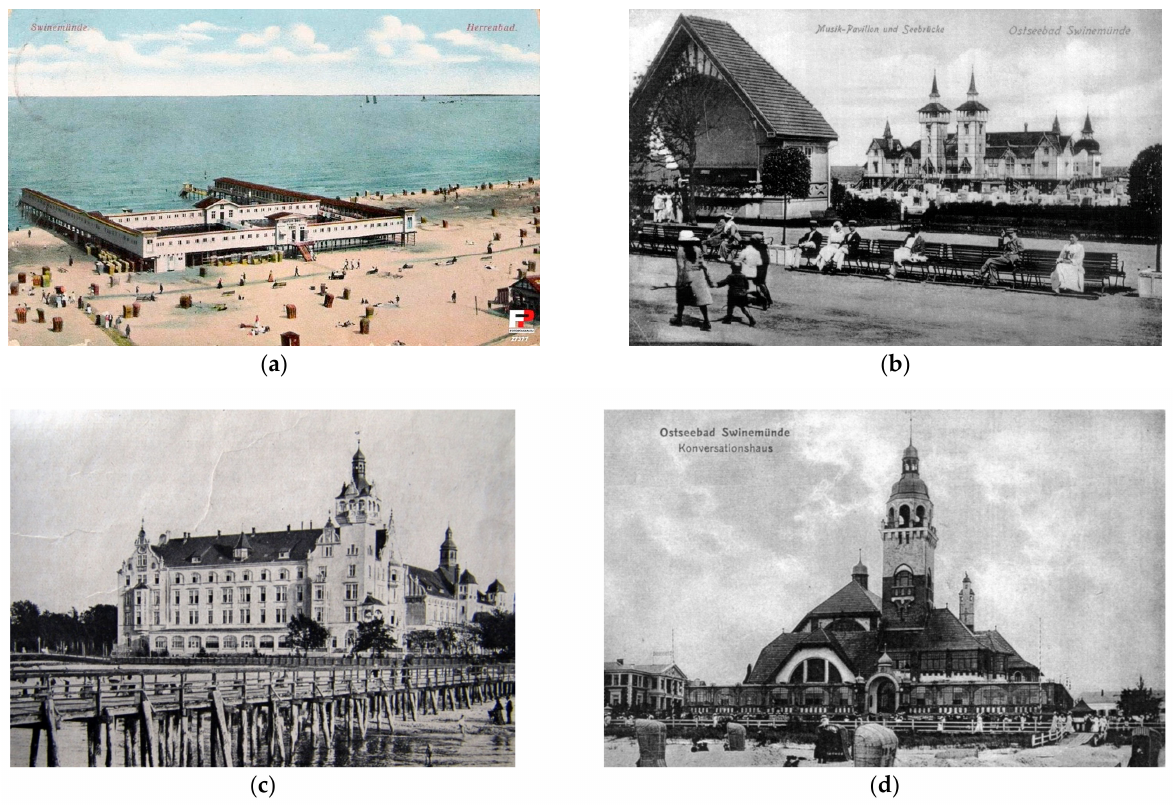
Figure 3. Nodal elements: ( a ) Swimming area in ´Swinouj´scie; ( b ) Concert shell and beach palace ( c ) Spa house in Kołobrzeg; ( d ) Spa house in ´Swinouj´scie. Source: Fotopolska.pl ( a ), Scans of archival postcards—Private collections of the author ( b , d